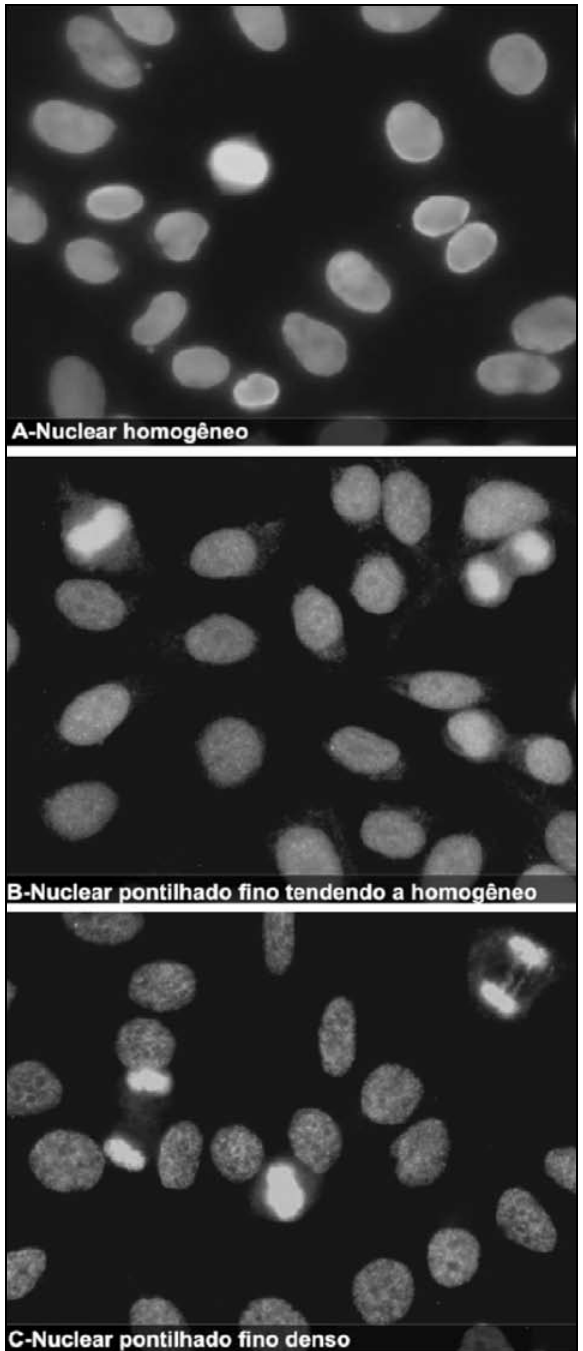
Figura 3 – Padrão nuclear pontilhado fino tendendo a homogêneo (B). As células apre- sentam nucleoplasma com textura de tendência homogênea e placa metafásica corada. Pode ser confundido com o padrão nuclear pontilhado findo denso (C), porém não é positivo para a proteína de 75Kda e para ser observado o padrão nuclear homogêneo.